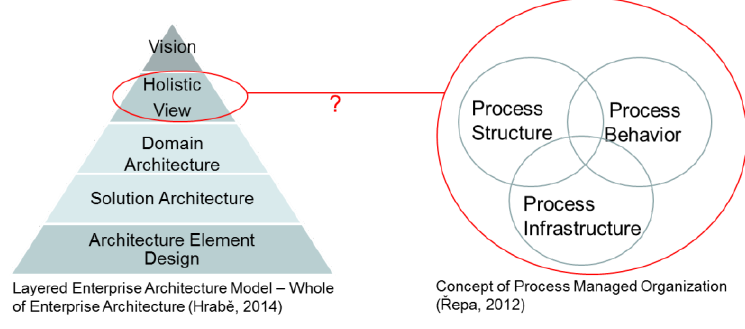
Figure 1. Problem